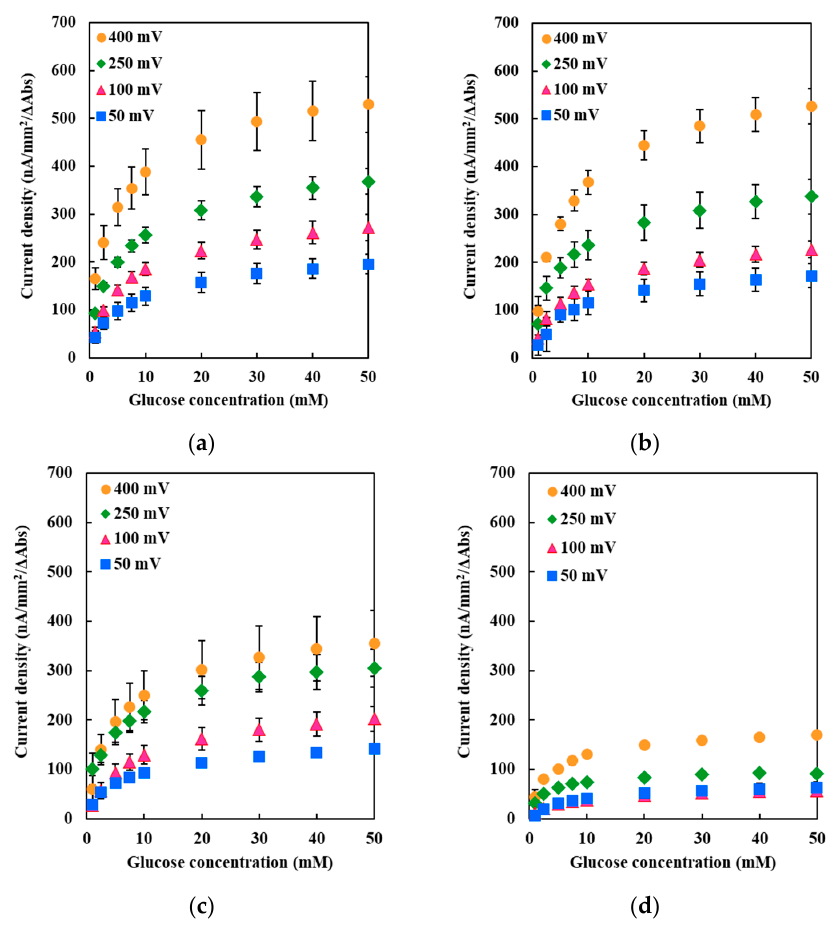
Figure 3. DET-type catalytic current measurement of the ( a ) WT, or mutant FADGDH ( b ) Met109His, ( c ) Met263His, and ( d ) Met386His-immobilized gold electrode. Buffer: 100 mM PPB (pH 7.0), 37 °C. Reference electrode: Ag/AgCl; counter electrode: Pt wire. Applied potential: +400, +250, +100, and +50 mV vs. Ag/AgCl.